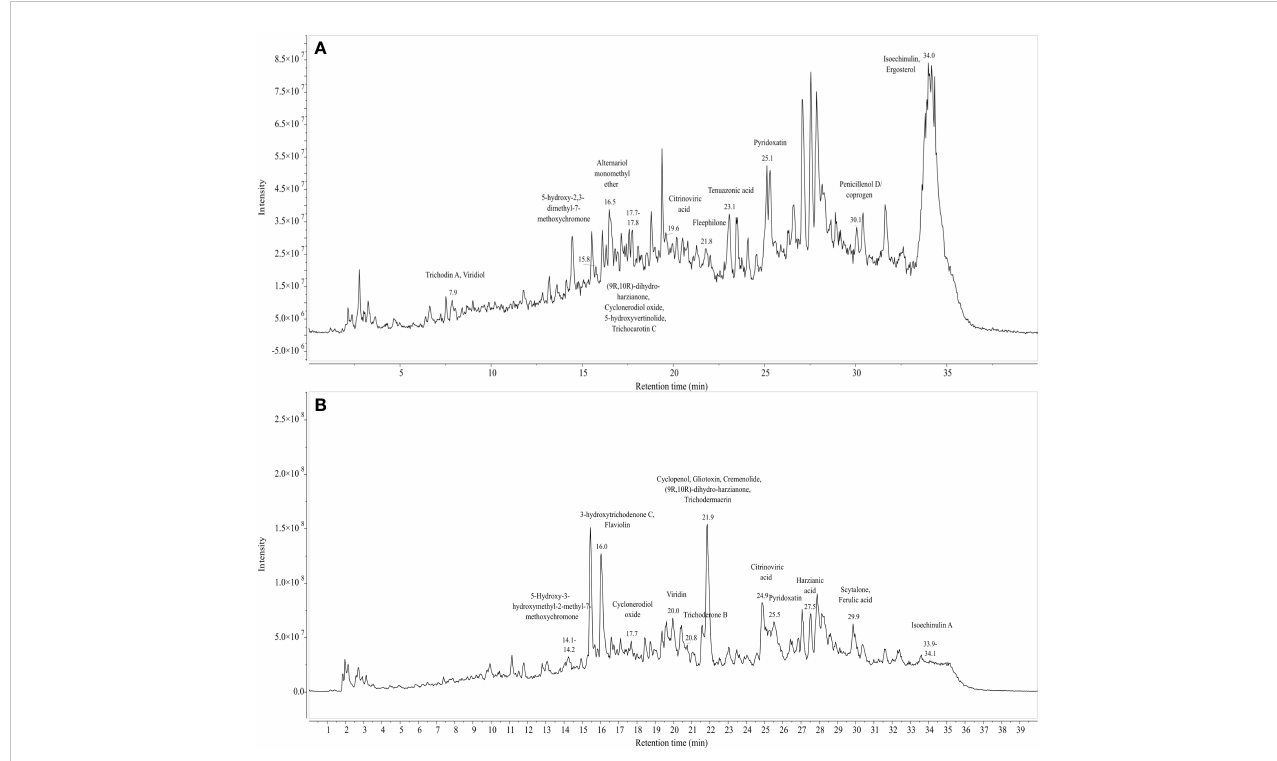
FIGURE 9 Total ion chromatogram of LC-MS-ESI of cell free fi ltrates of Trichoderma isolates which outstood the in vitro antagonistic assays. (A) NBG (B)